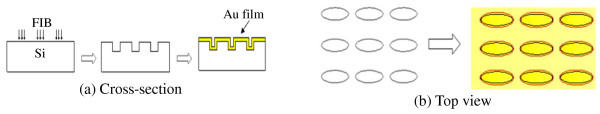
Schematic images of the process of FIB pre-milling with the following thermal evaporation. (a) Cross section of the nanostructures before and after thermal evaporation. We can clearly find that the spacing becomes smaller after depositing gold film; (b) top view of the nanostructures. It describes the change of the nanostructures’ morphology.